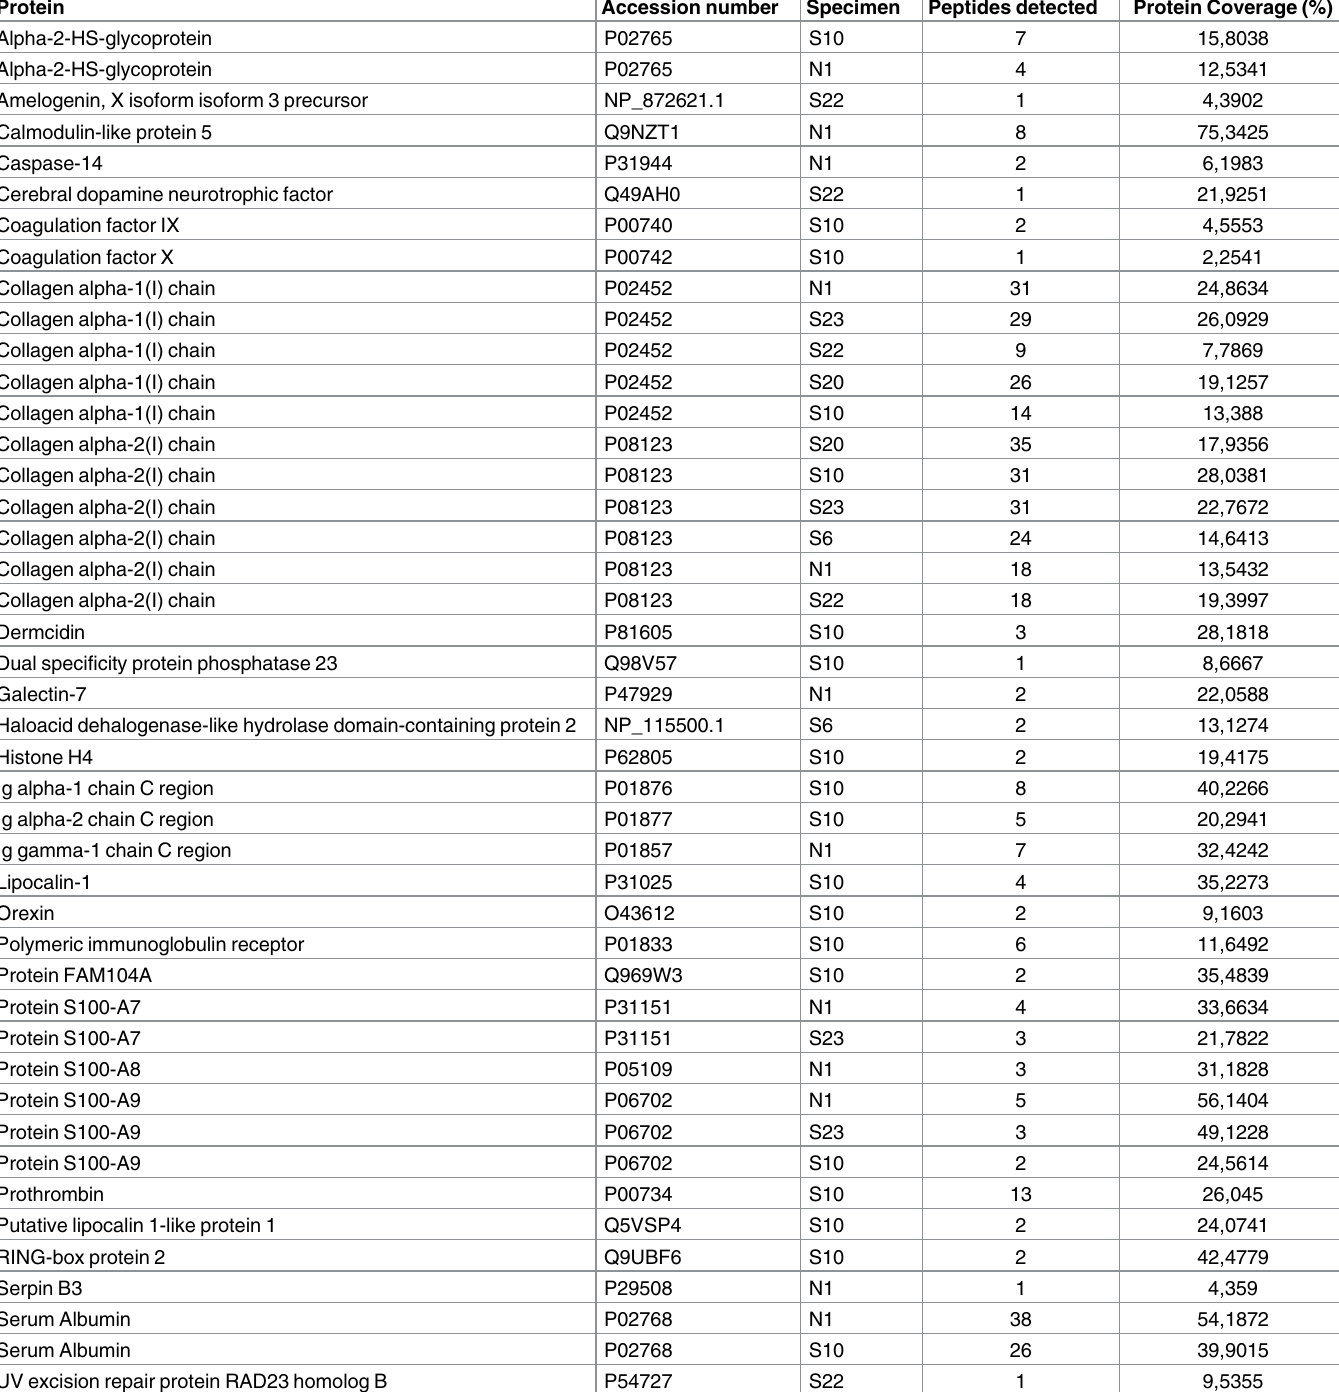
Table 1. List of human proteins (except for keratins, interpreted as contaminants) identified by paleoproteomic investigations of 16 ancient dental pulp specimens collected in two archeological sites, France.